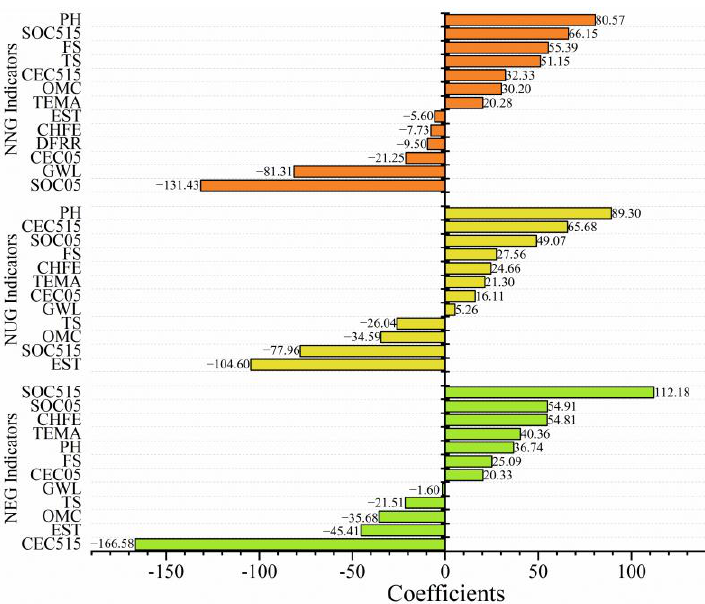
Figure 4. Coefficients of generalized regression model between the selected indicators of the corre- lation analysis and the CLQ grade indices.